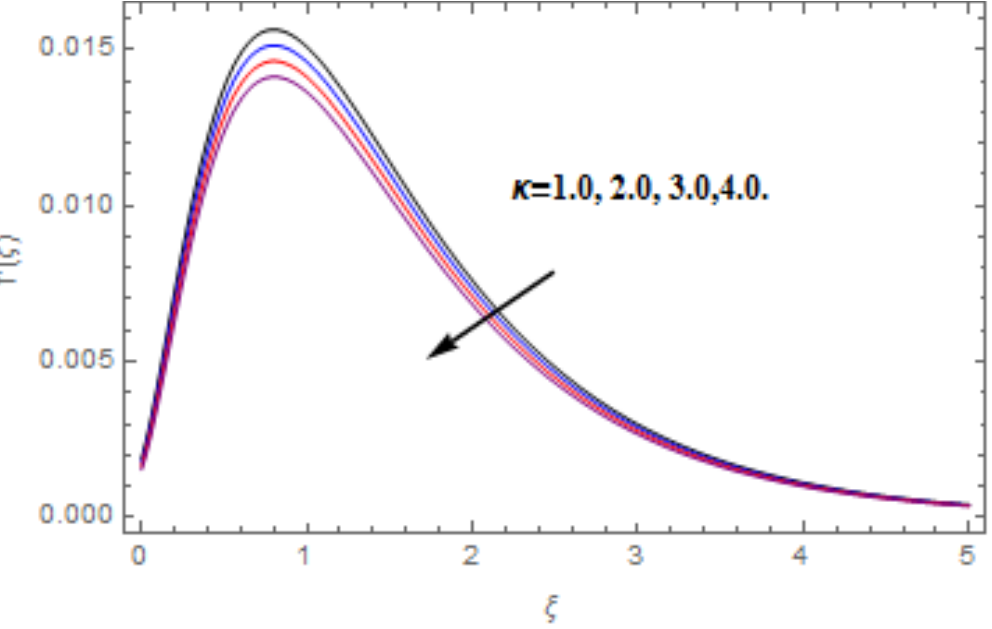
Figure 6. Varation in f (cid:48) ( ξ ) gainst κ , when M = ψ = 0.2, Nt = Nb = 0.5, Le = 1.0, Ec = 1.0, Pr = 1.2, Figure 6. γ =